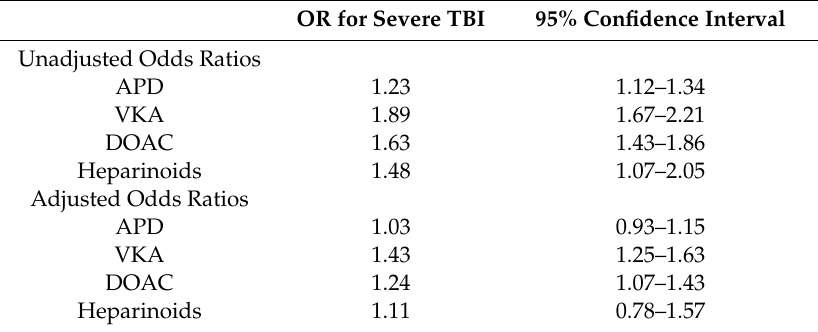
Table 4. Multivariate Logistic regression analysis with severe TBI (AIS 4 / 5 / 6) as a dependent variable. OR for di ff erent types of anticoagulation therapy (reference group is no medication), without adjustment and after adjusting for age, gender, type of accident, and concomitant